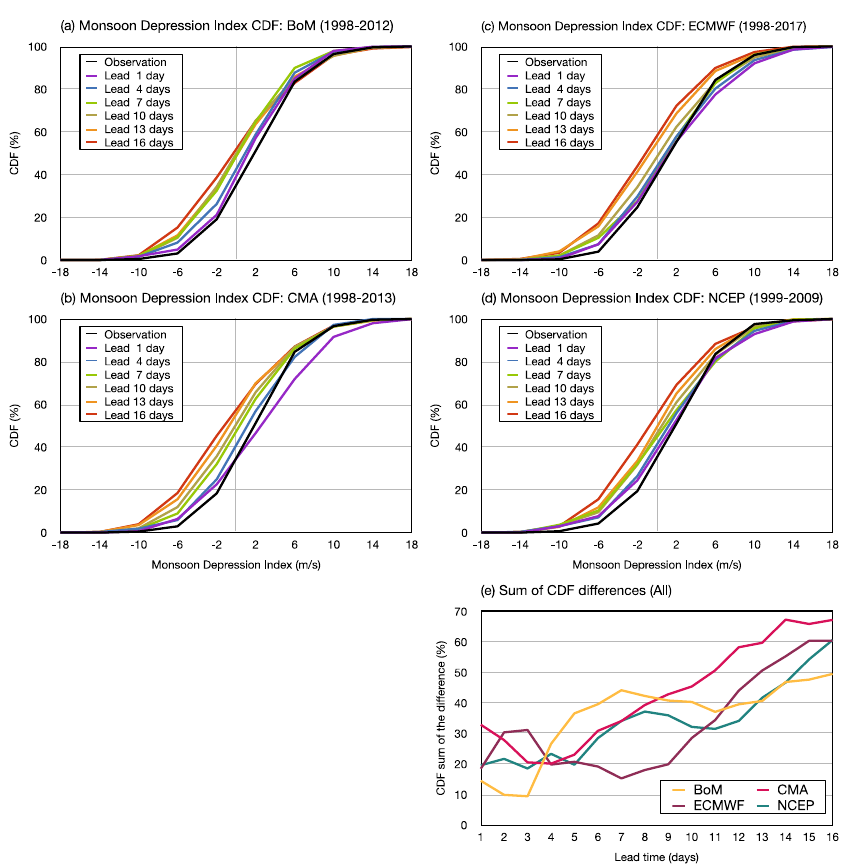
Figure 7. The cumulative distribution function (CDF) of the monsoon depression index anomalies (obtained by subtracting the averages of Days -15 to 29 for each year) represented by 850-hPa zonal wind shear (Figure 2c) in observation (black curves) and ( a ) BoM, ( b ) CMA, ( c ) ECMWF, and ( d ) NCEP S2S models for lead times 1, 4, 7, 10, 13, and 16 day(s) during the 15-day SPREs period in the available years in hindcast datasets. ( e ) illustrates the sum of CDF difference between S2S models and observation varying with lead time. The hindcast years of BoM hindcast model are from 1998 to 2013, CMA from 1998 to 2012, ECMWF from 1998 to 2017, and NCEP from 1998 to 2009. The verification results for the 2018/19 SPRE are presented in Figure 8. The observa- tional (ERA-Interim) CDF curve suggests that for this case, the monsoon depression index